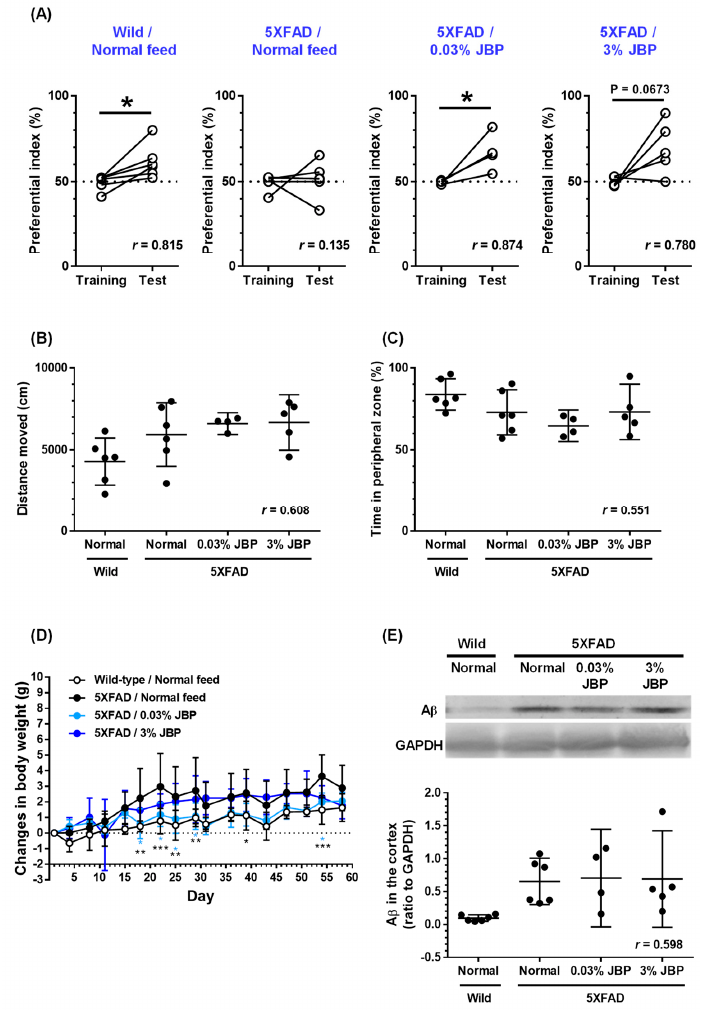
Figure 1. Effect of oral administration of JBP-F-02 on object recognition memory deficit in young 5XFAD mice . ( A ) JBP-F-02 mixed feed (0.03% and 3%) or a normal feed was administered for 58 days to mice (male and female, 13 weeks old). An object recognition test was carried out at day 43 with a 24 h interval between the training session and test session. The preferential indices of the training and test sessions are shown; * p < 0.05, two-tailed paired t -test. ( B ) Distance moved in an open field for 10 min; p > 0.05, one-way ANOVA. ( C ) Spent time as a percentage in peripheral zone of an open field. The peripheral zone was defined as a 5 cm wide area from the edge line; p > 0.05, one-way ANOVA. ( D ) Changes in body weights of mice during the experimental period; * p < 0.05, ** p < 0.01, *** p < 0.001 vs. normal feeding 5XFAD mice, repeated measures two-way ANOVA with post hoc Bonferroni’s test. ( E ) Oligomeric A β expression in the cerebral cortex; one-